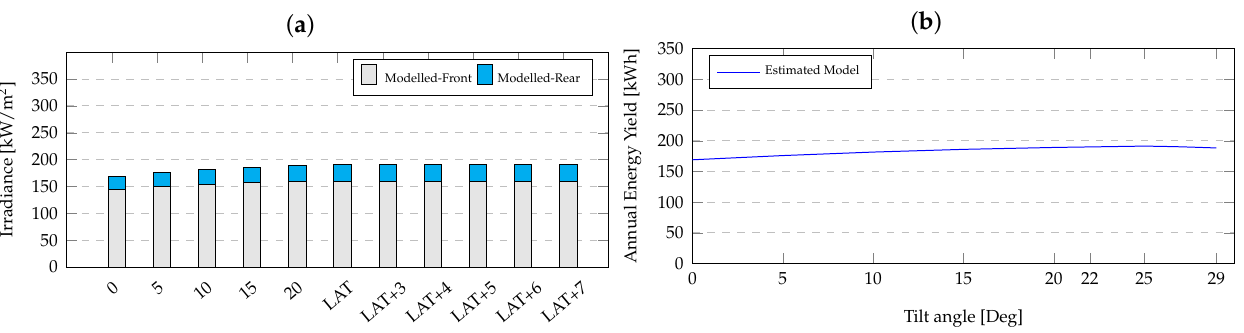
Figure 8. Optimization of the tilt angle measuring ( a ) irradiance and ( b ) annual energy yield for the SN tilted orientation ( a ), Location—Kharagpur.